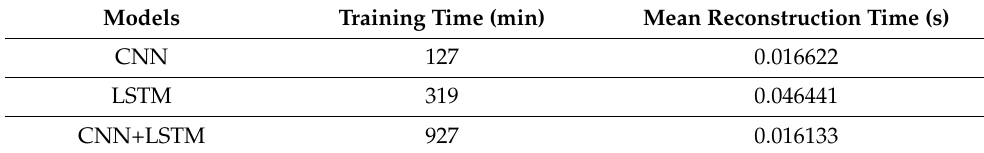
Table 9. Time of training and reconstruction of neural network